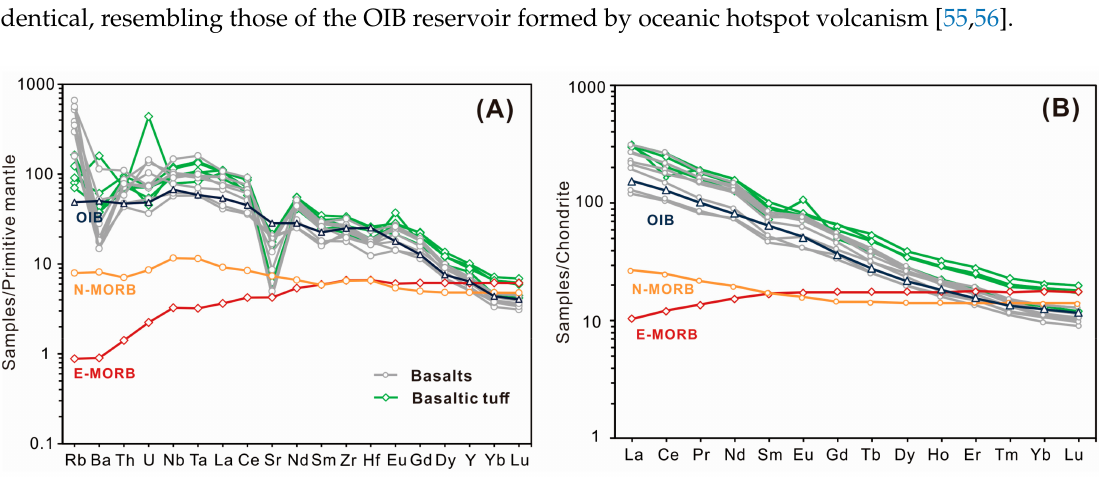
Figure 9. Primitive mantle-normalized trace element diagrams. ( A ) and chrondrite-normalized rare earth element (REE) patterns ( B ) for the Laochang basalt and basaltic tuff. The primitive mantle and chrondrite values are from Sun and McDonough